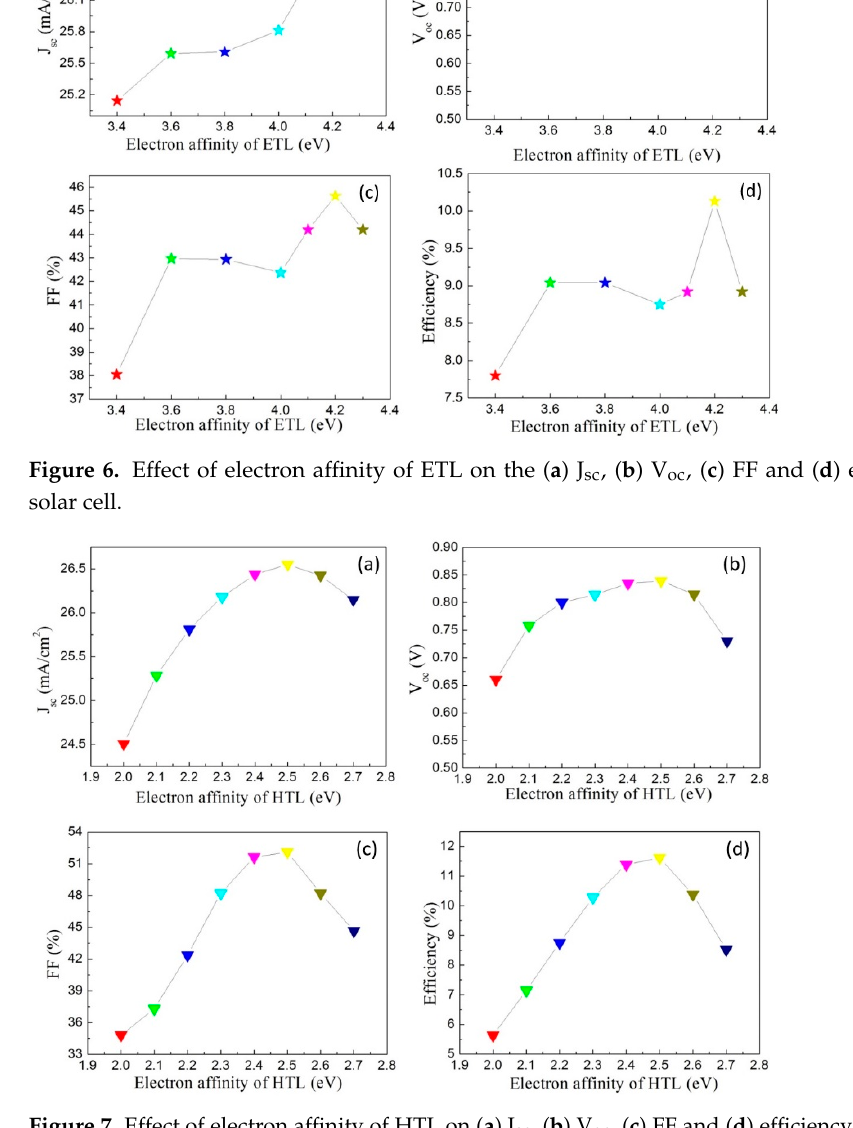
Figure 7. Effect of electron affinity of HTL on ( a ) J sc , ( b ) V oc , ( c ) FF and ( d ) efficiency of the solar cell.